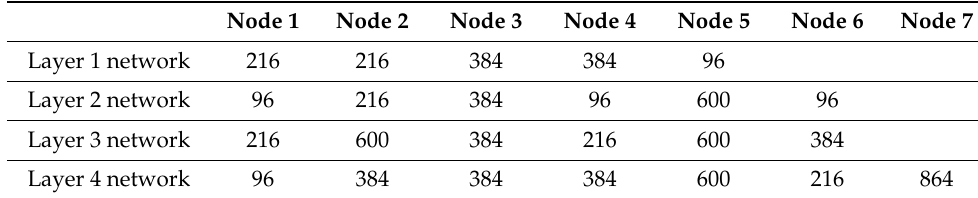
Table 5. Node capacity per layer.